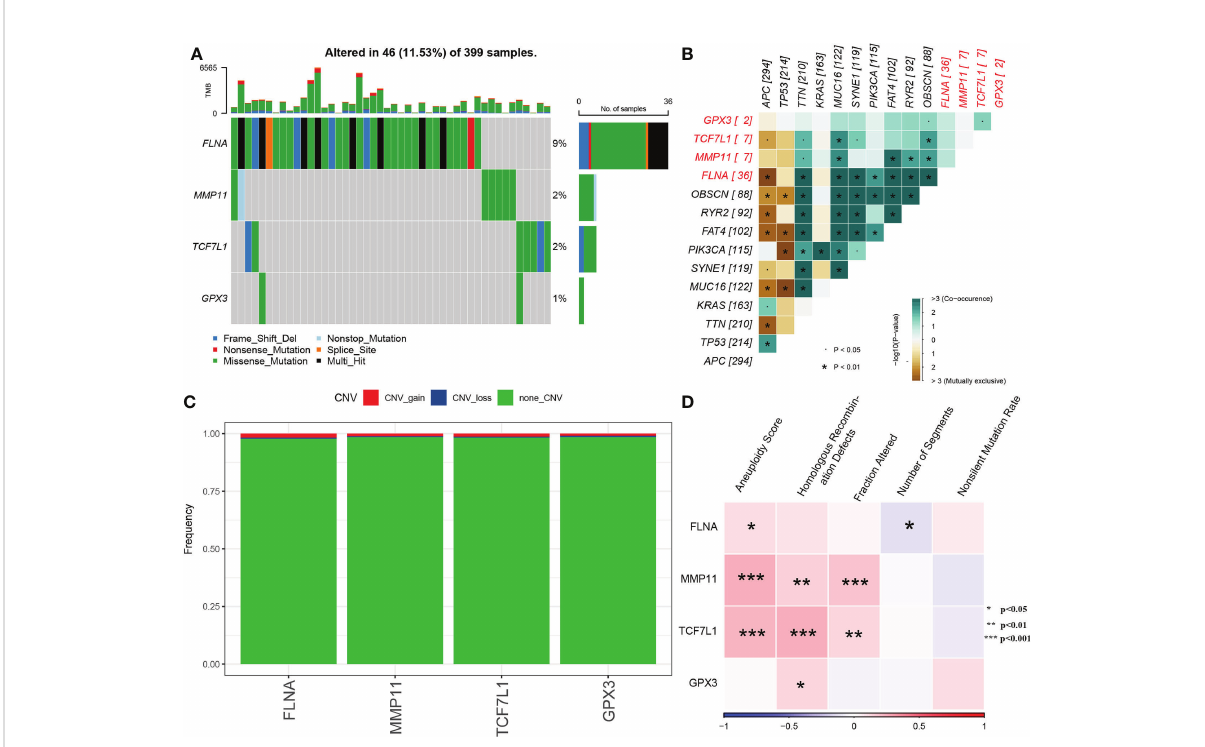
FIGURE 5 (A) Waterfall diagram of SNVs in the 4 key genes; (B) Collinearity and mutual exclusion analysis of the 4 key genes and 10 genes with the most mutations in CRC; (C) CNVs in the 4 key genes; (D) Heat map of the correlation between the 4 key genes and aneuploidy scores, homologous recombination defects, fraction altered, number of segments and non-silent mutation rates.